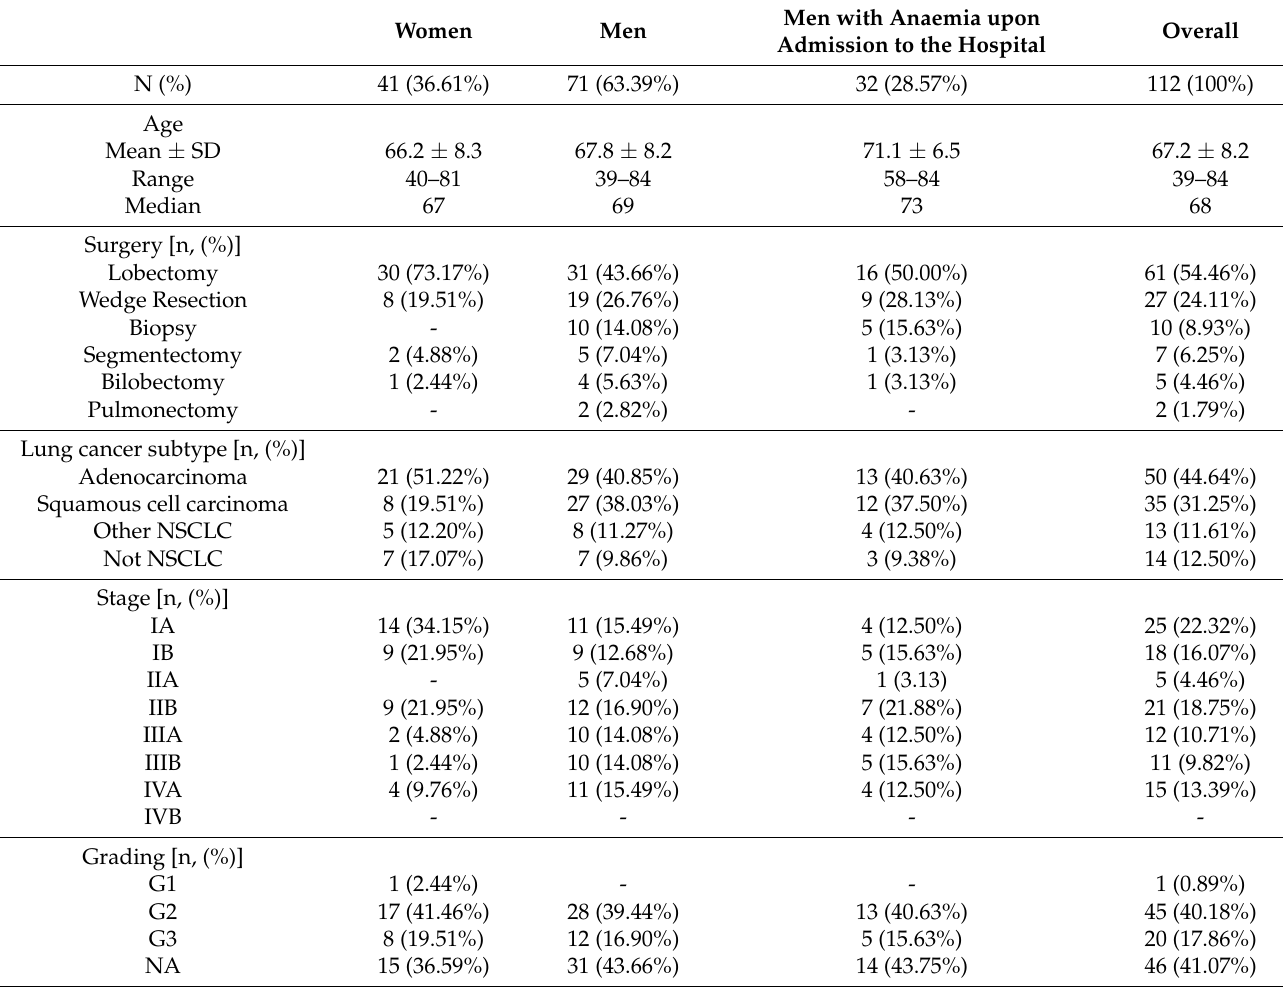
Table 2. Lung cancer patients’ characteristics divided by